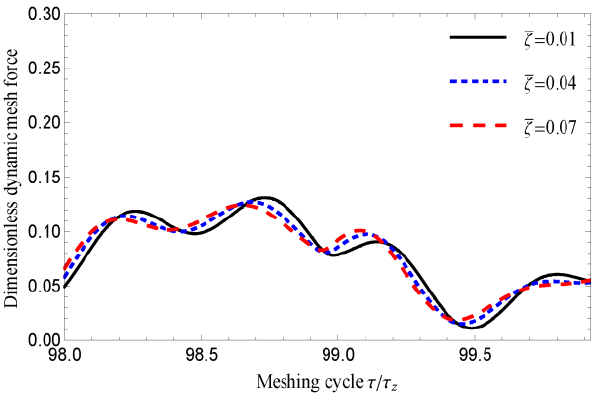
Figure 28. Dynamic mesh force of a single pair of teeth under different 𝜁̅ .